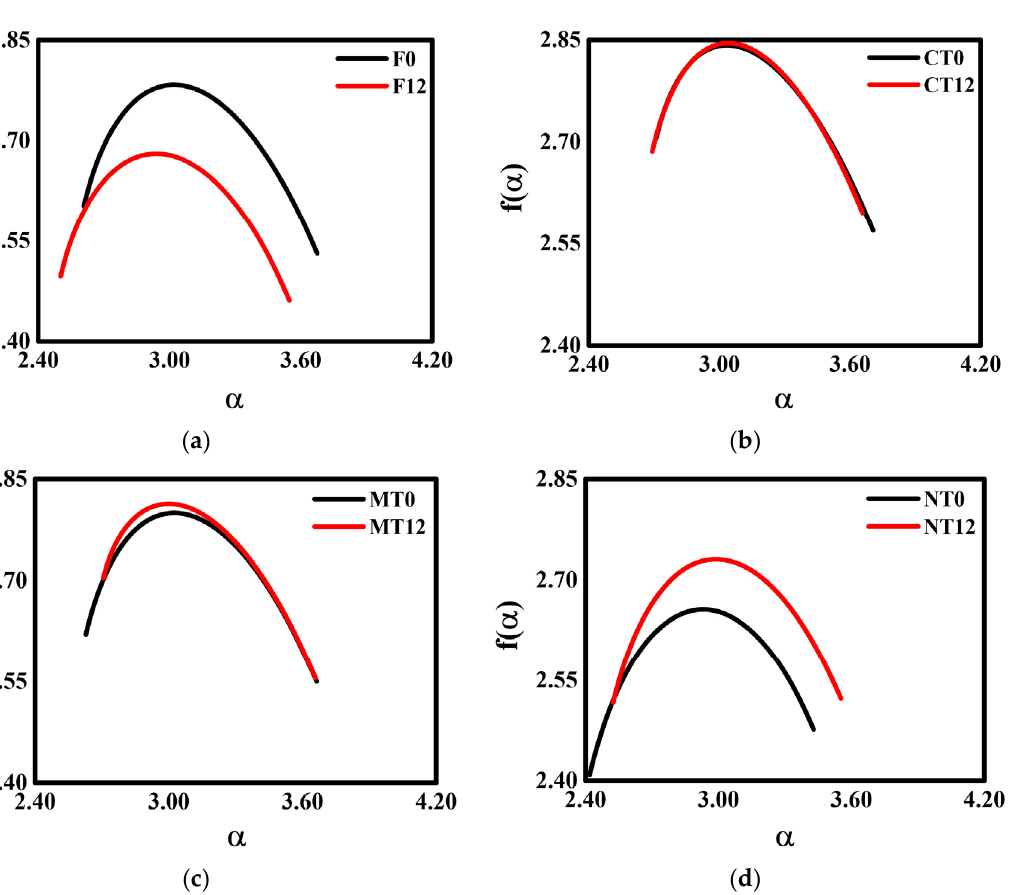
Figure 3. Multifractal spectra (f( α ) versus α ) of the samples subjected to 0 and 12 wetting and drying (W-D) cycles. ( a ) Secondary forest—F; ( b ) conventional tillage—CT; ( c ) minimum tillage—MT; ( d ) no tillage—NT.